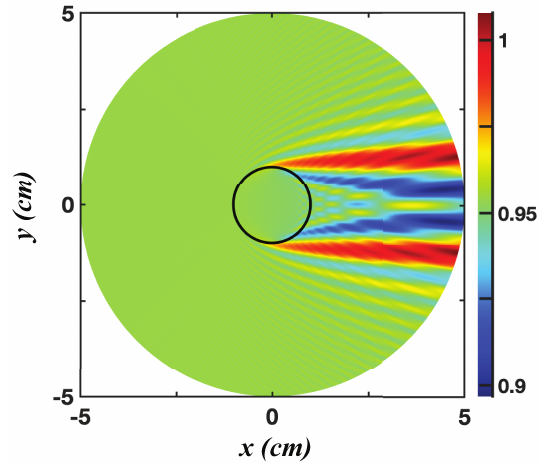
Figure 4. Scattering of an O mode, incident from the left, by a filament of radius 1 cm centered at the origin. The normalized, time-averaged Poynting flux in the x -direction < S x > / | < (cid:126) S I > | is plotted in the x - y plane; (cid:126) S I is the total Poynting vector of the incident wave. The electron density of the background plasma is n eb = 5 × 10 18 m − 3 while inside the filament it is n ef = 6 . 5 × 10 18 m − 3 ; the wave frequency is 170 GHz, the magnetic field is 5 T and pointing in the z direction, and the incoming wave has ck (cid:107) /ω = 0 . 3.